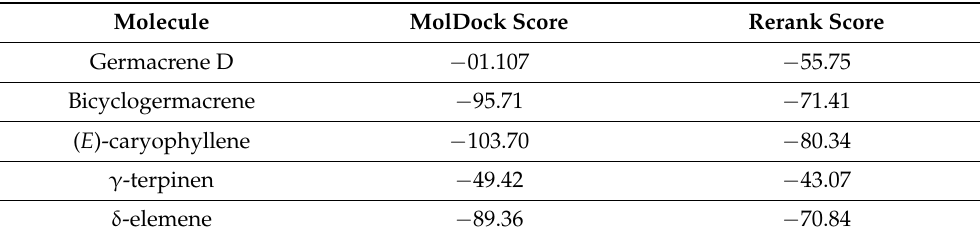
Table 3. Moldock scores obtained from the docking protocol using MVD 5.5.